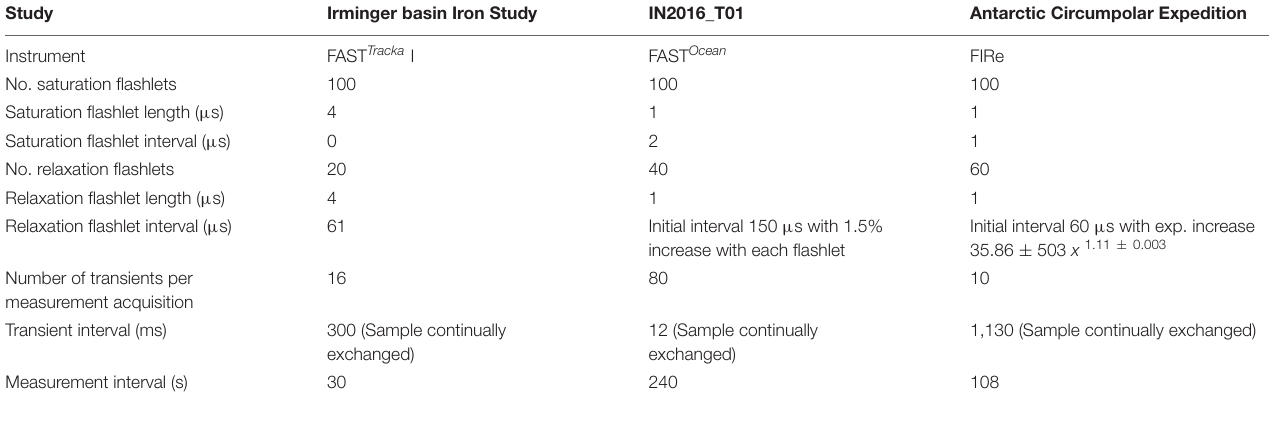
TABLE 1 | Data collection protocols for the data presented as application of the Phytoplankton Photophysiology Utilities